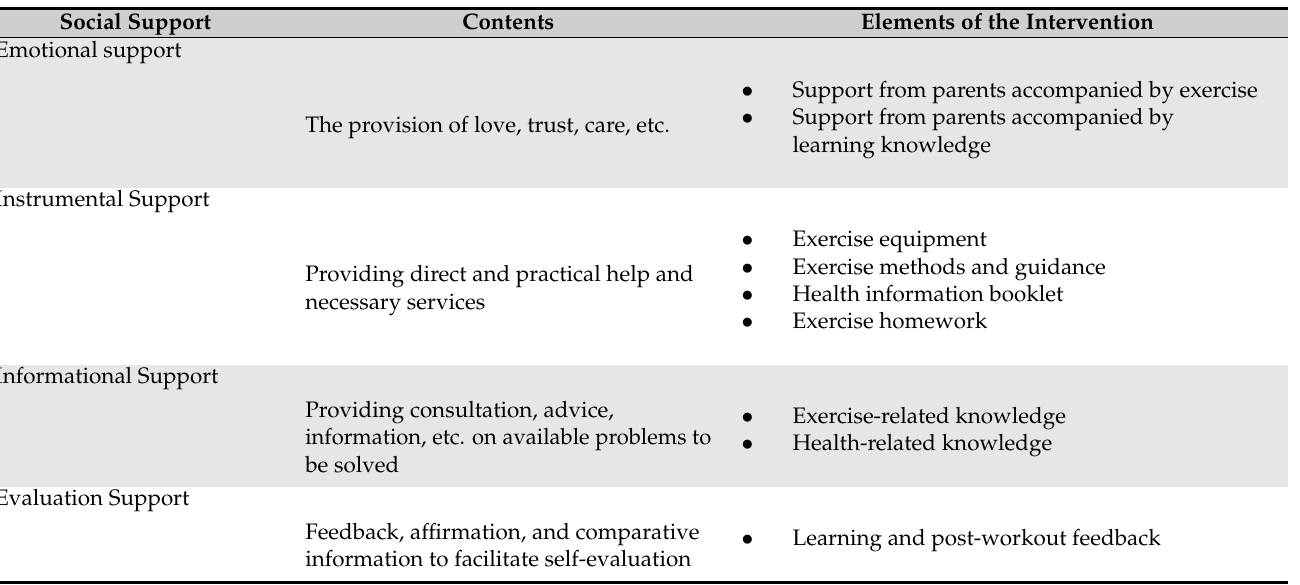
Table 1. Design of intervention elements based on social support